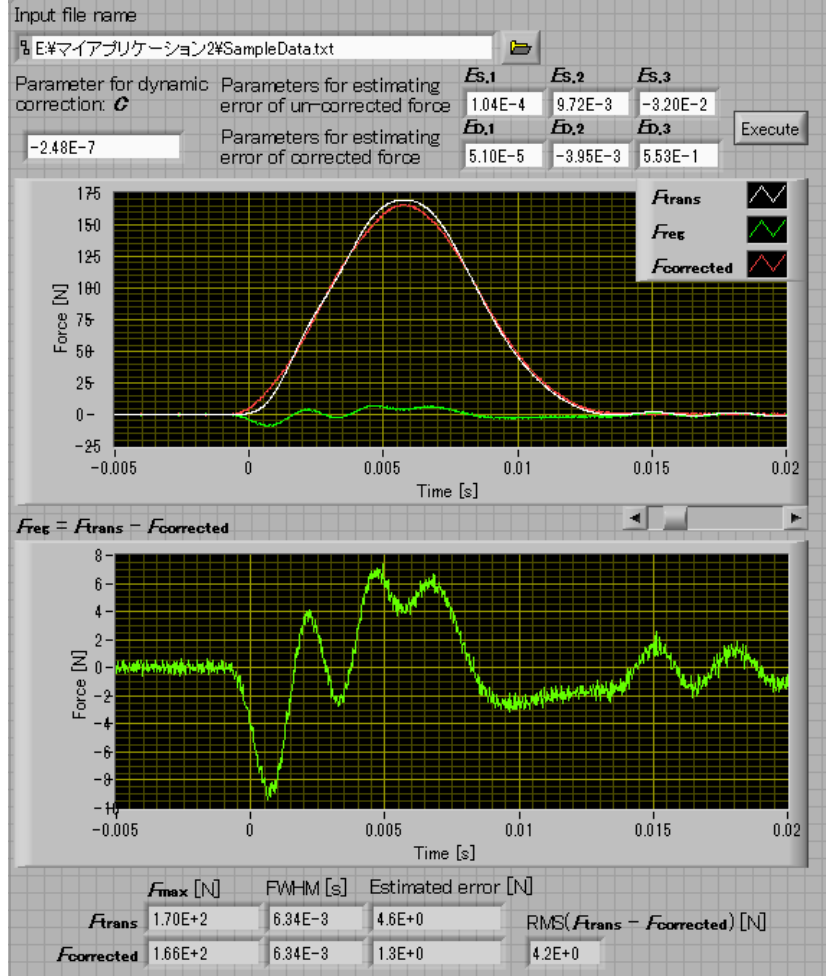
Figure 8. Screenshot of the correction